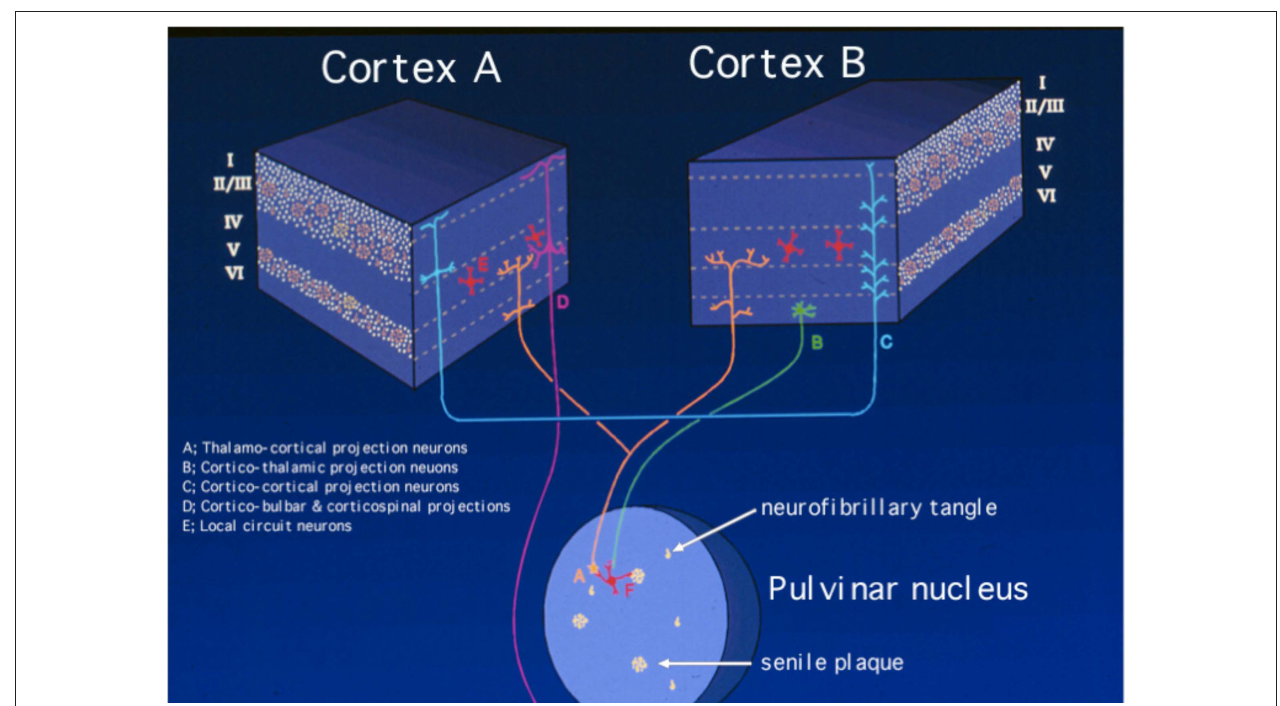
focuses on the circuitry affected and is limited to the resolution of the light microscopy. Thus, while it helps to understand the connections that are affected and to establish their correlation with the clinical manifestations of the disorder, it does not convey information about the ultrastructural, electrophysiological, functional imaging, and molecular domains, among